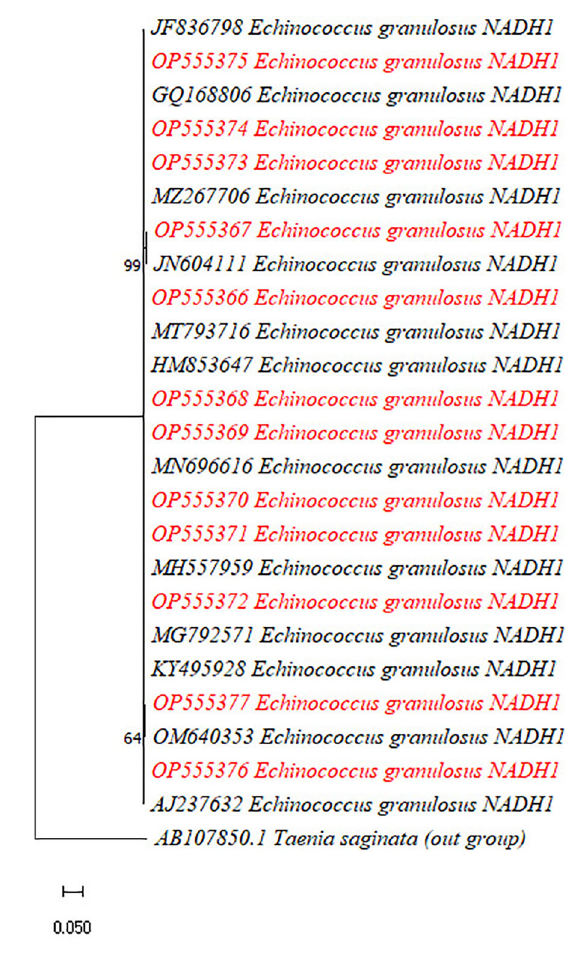
FIGURE 5 Phylogenetic analysis of the currently identi fi ed Echinococcus granulosus species based on the Nad1 gene. The phylogenetic tree was constructed in MEGA X software using maximum likelihood (Taimura – Nei) methods with a bootstrap value of 1,000.